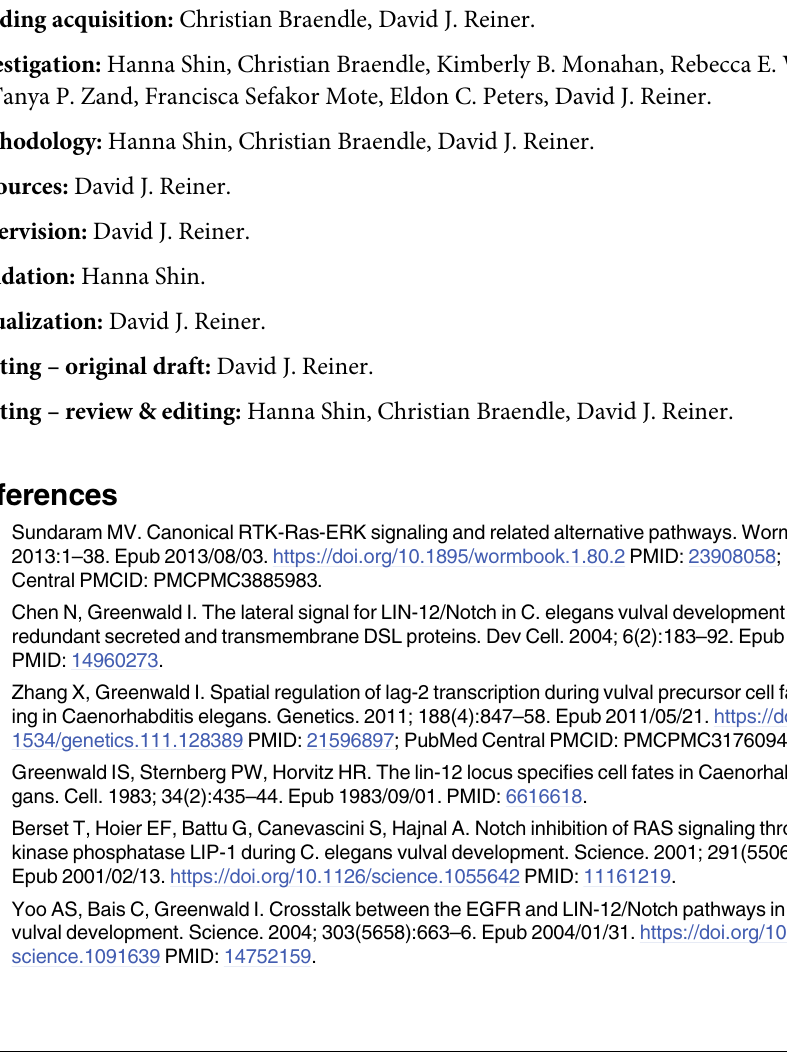
S2 Table. Primers. A list of all primers used in this study.